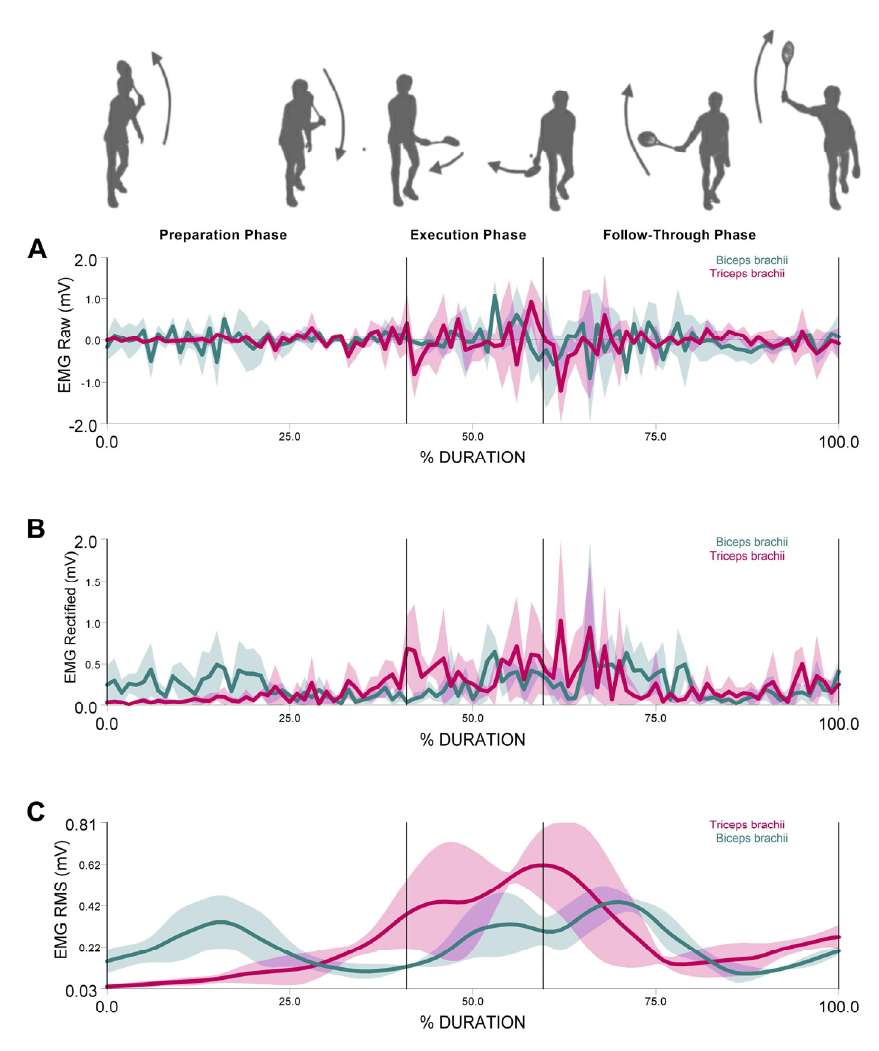
Figure 1. Backhand crosscourt phases (Preparation phase, Execution phase, Follow-Through phase) of the Biceps brachii (BB) and Triceps brachii (TB). ( A ) EMG raw data, ( B ) EMG rectified data, and ( C ) EMG RMS. Means (solid lines) and standard deviation (shaded areas) of three stroke attempts from a representative subject.